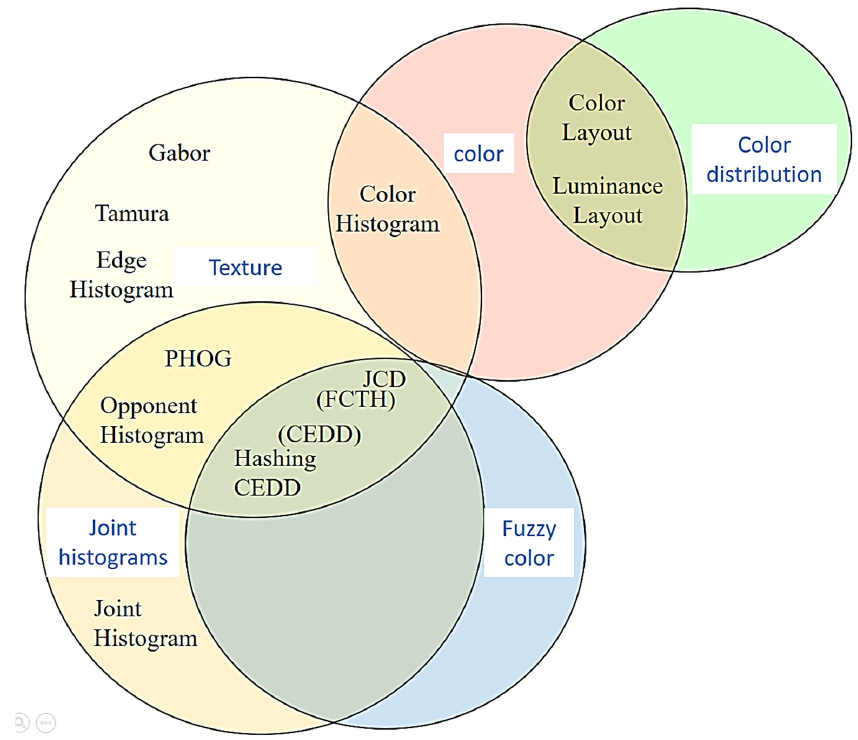
Electronics 2021 , 10 , x FOR PEER REVIEW Figure 4. Categories of the used image descriptors. Figure 4. Categories of the used image descriptors.